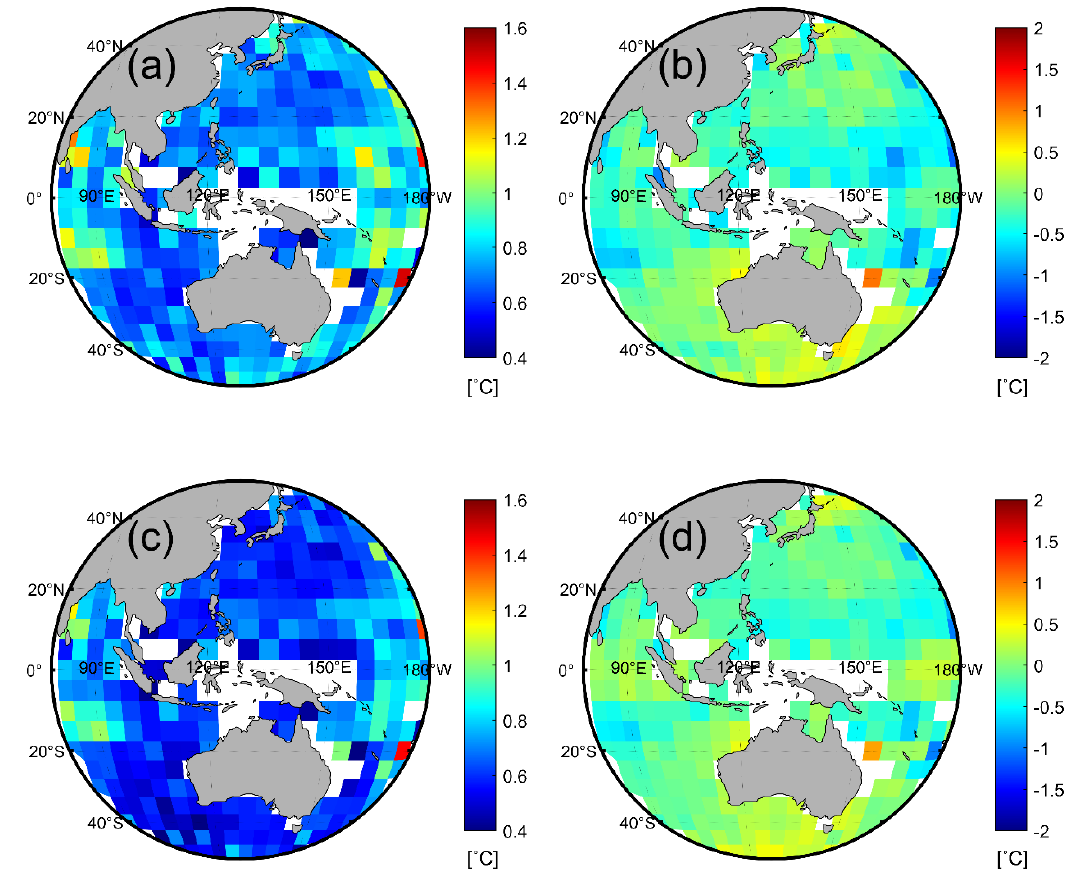
Figure 12. Spatial distribution of ( a ) root mean square errors (RMSEs) and ( b ) mean biases of MCSSTs and ( c ) RMSEs and ( d ) mean biases of NLSST from in situ temperatures in bins of 5° × 5° for the period from April 2014 to March 2015.